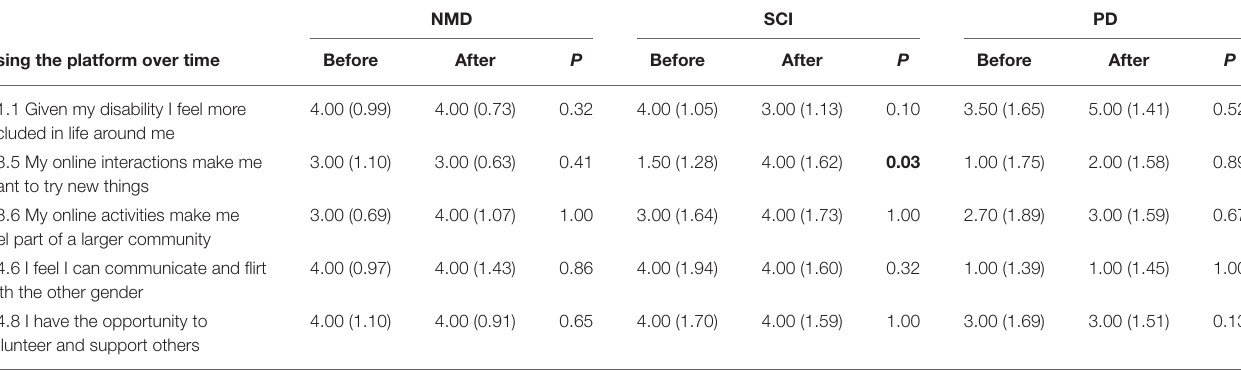
TABLE 4 | Descriptive statistics (median and standard deviation) for “Before” and “After” answers on participation social indicator questions and comparison using Wilcoxon non-parametric statistical test. NMD SCI PD Using the platform over time Before After P Before After Before